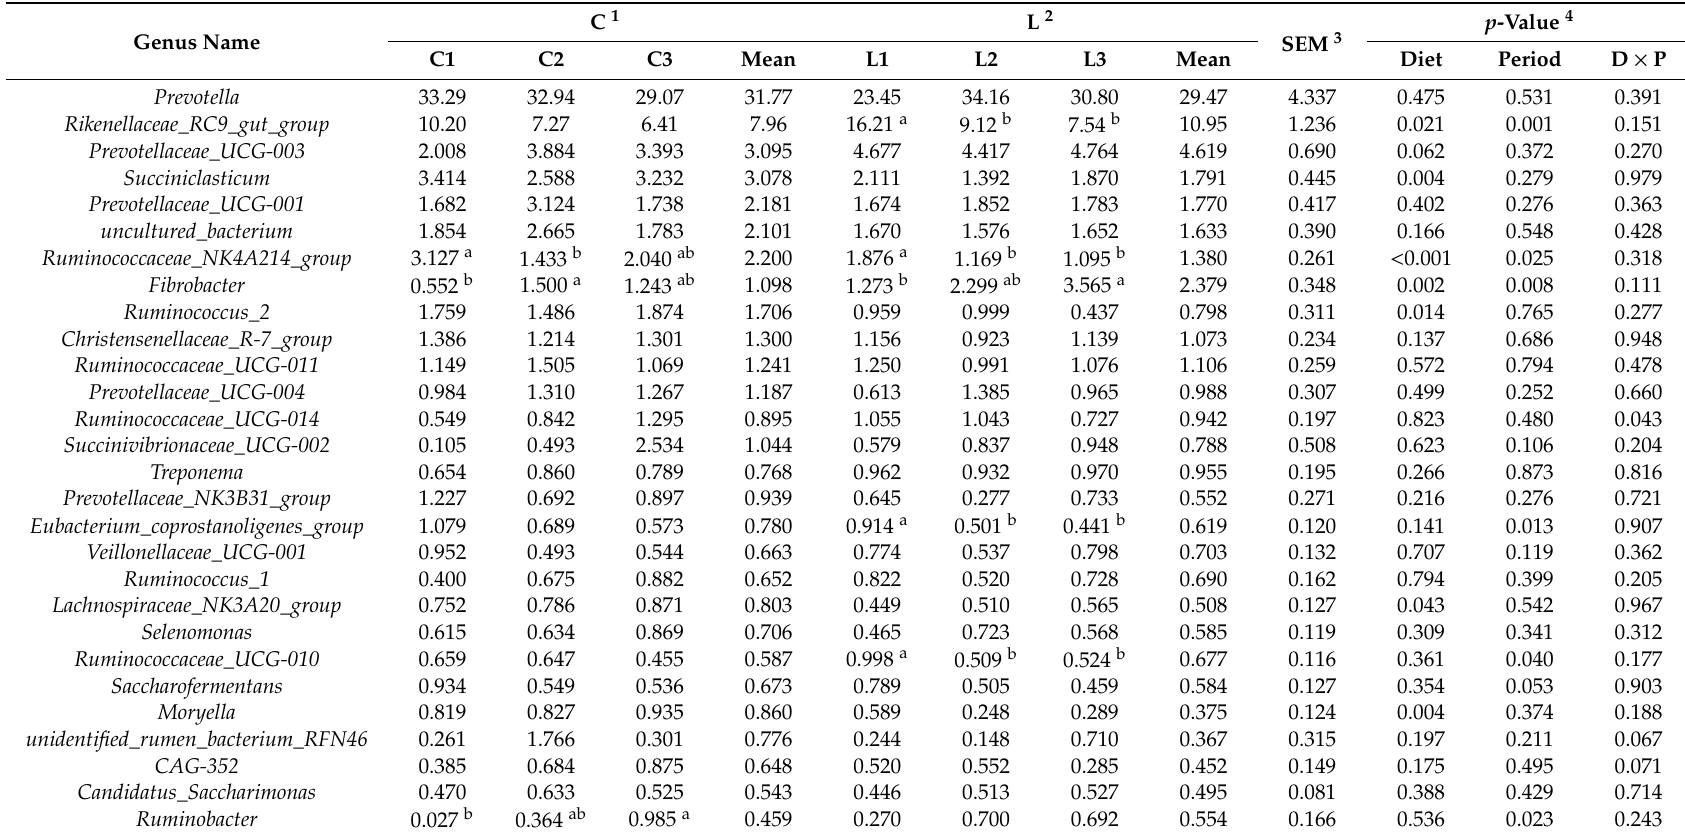
Table 4. Genus (relative abundance > 0.5%) composition for rumen samples collected at three monthly intervals in two diet